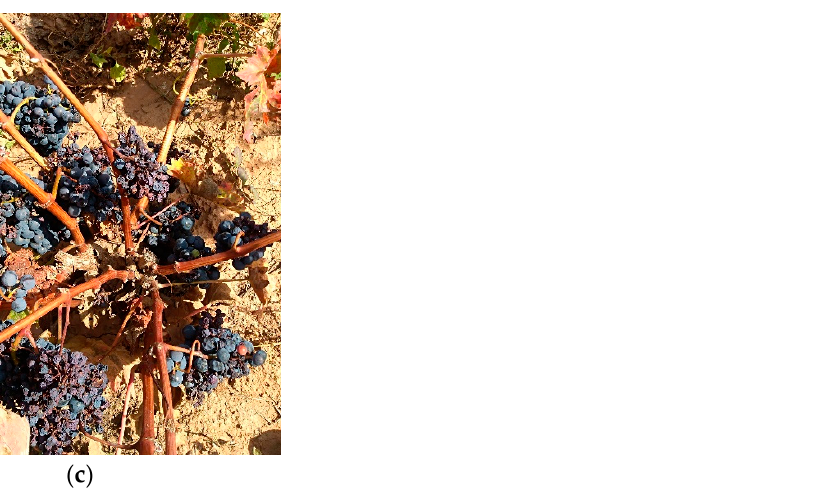
Figure 9. Health status of ( a ) BABA-treated grapes; ( b ) distilled water-treated grapes (control) and ( c ) Greetnal-treated grapes from plot A at harvest (24 October 2018).